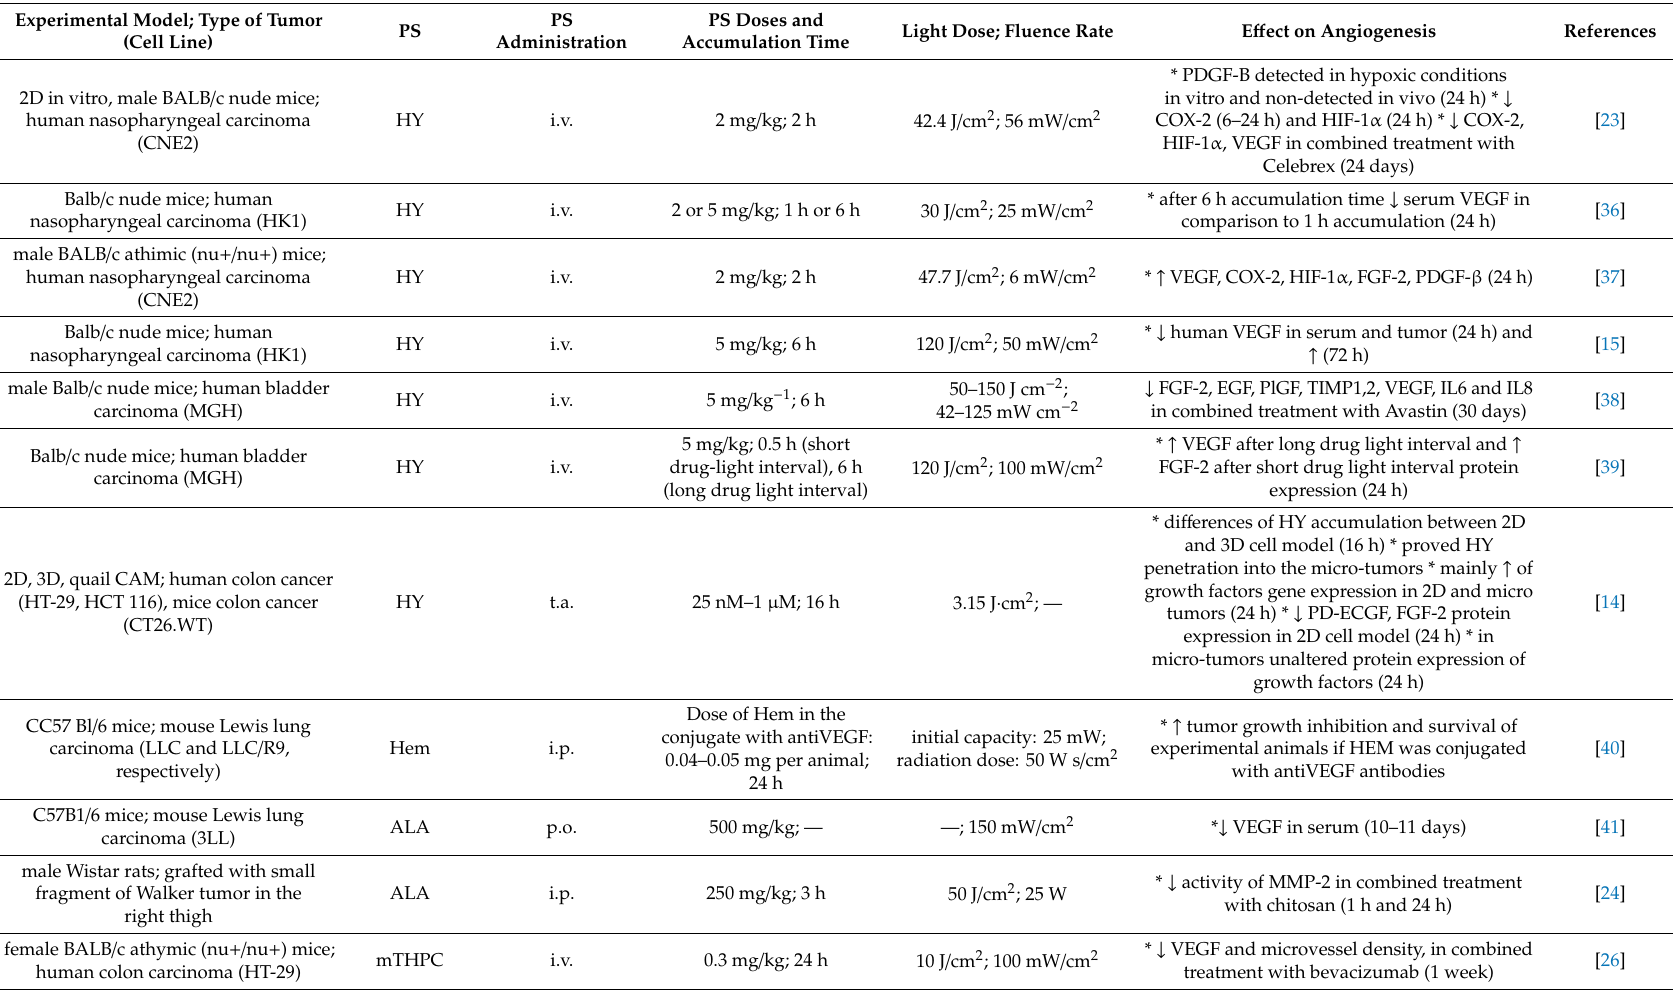
Table 1. In vivo experimental models utilized for photodynamic therapy (PDT) in relation to angiogenesis, focused on analyses of angiogenic factors. Experimental Model; Type of Tumor (Cell